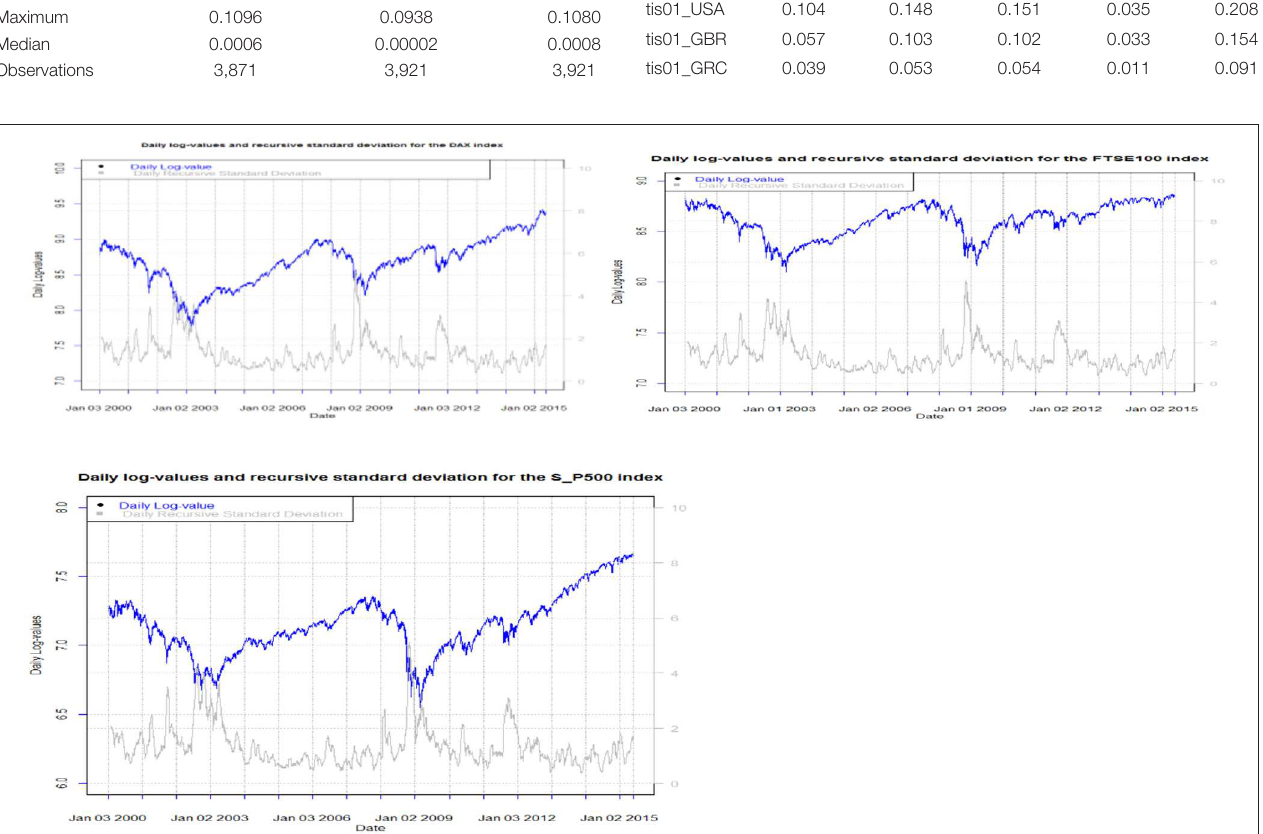
FIGURE 3 | Daily logvalues and recursive standard deviation of returns for all